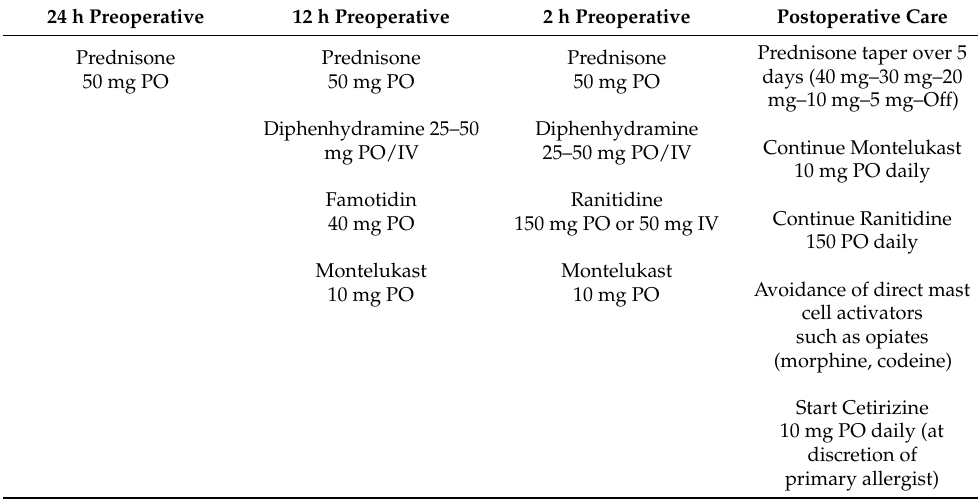
Table 5. Recommendation for the pharmacological prevention of mast cell degranulation in SM according to Duggal et al. modified